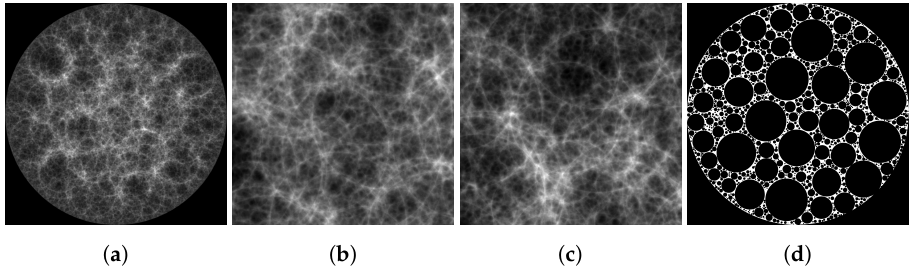
Figure 6. ( a ) A projection image of the foam ball; ( b ) a magnified projection image of the central region of interest (ROI); ( c ) a magnified projection image of the upper ROI; ( d ) the central cross-sectional slice of the